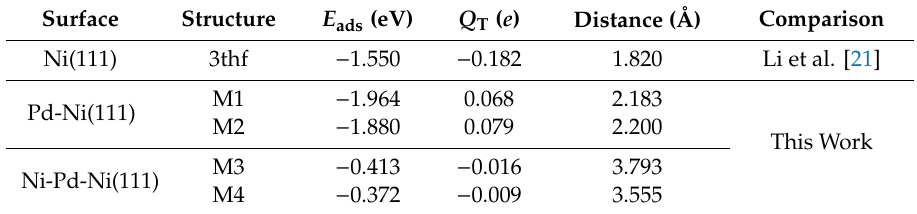
Table 1. The adsorption parameters of SOF 2 adsorbed by Ni(111), Pd-Ni(111), and Ni-Pd-Ni(111)